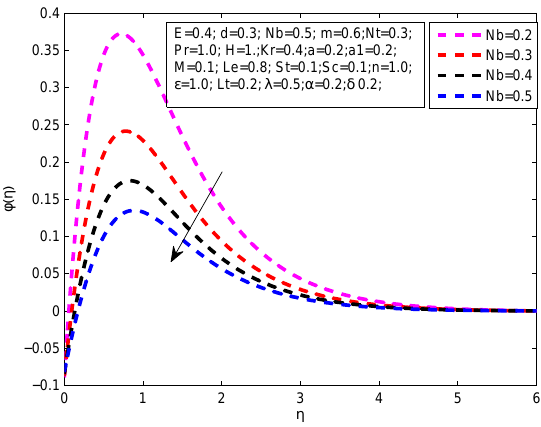
Figure 11. Variation of φ for distinct values of Nb .